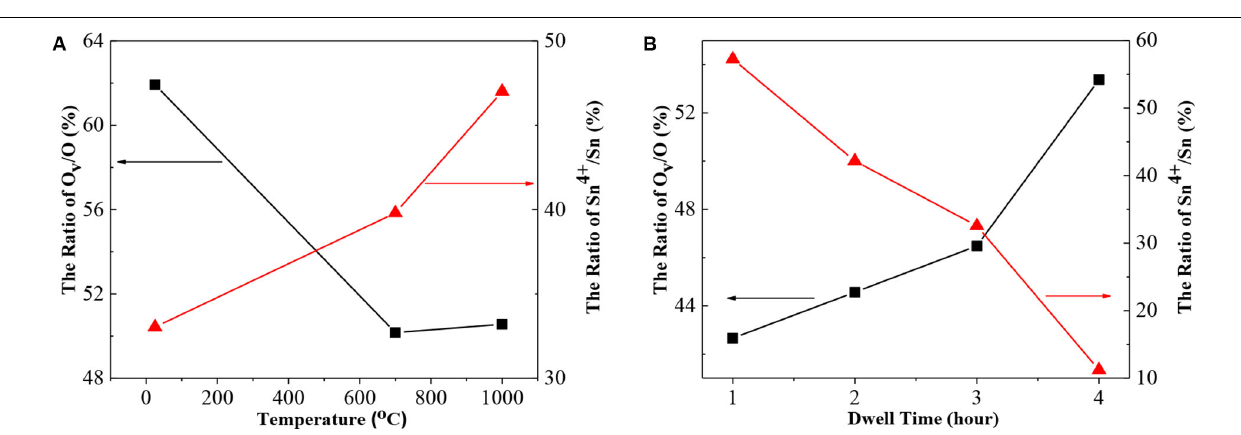
ratio of Sn 4 + ions to all Sn ions increases from 32.5 to 47.0% with temperature increasing from room temperature to 1,000 ◦